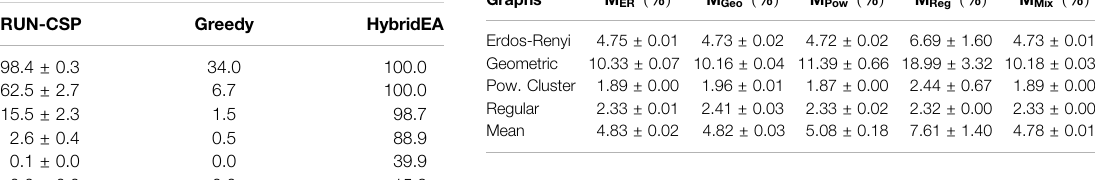
TABLE5| 3-COL:Percentagesofhard3-colorableinstancesforwhichoptimal3- colorings were found by RUN-CSP, Greedy, and HybridEA. We evaluate on 1,000 instances for each size. We provide mean and standard deviation across fi ve different RUN-CSP models. Nodes RUN-CSP Greedy HybridEA